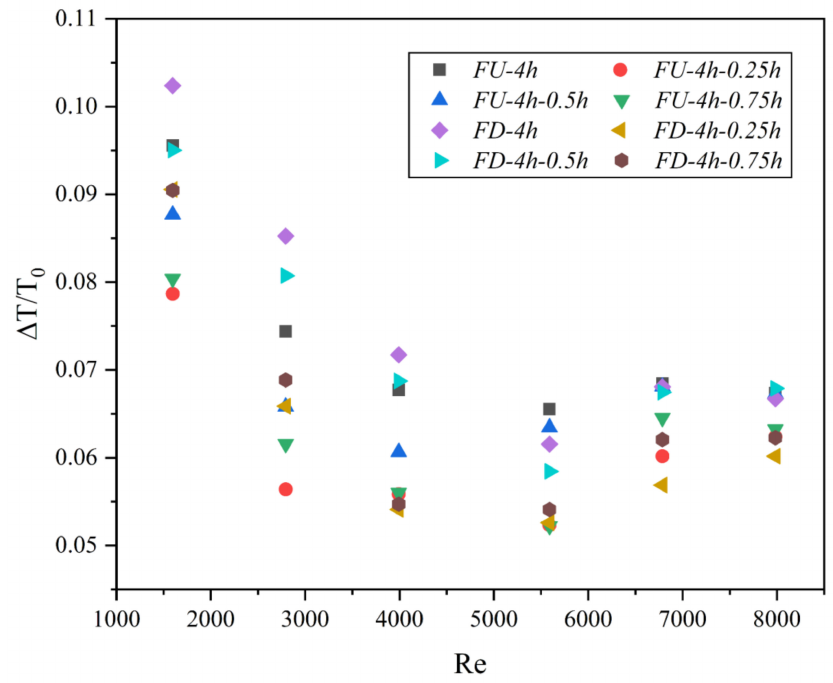
Figure 12. Performance of thermal enhancement factor ∆ T